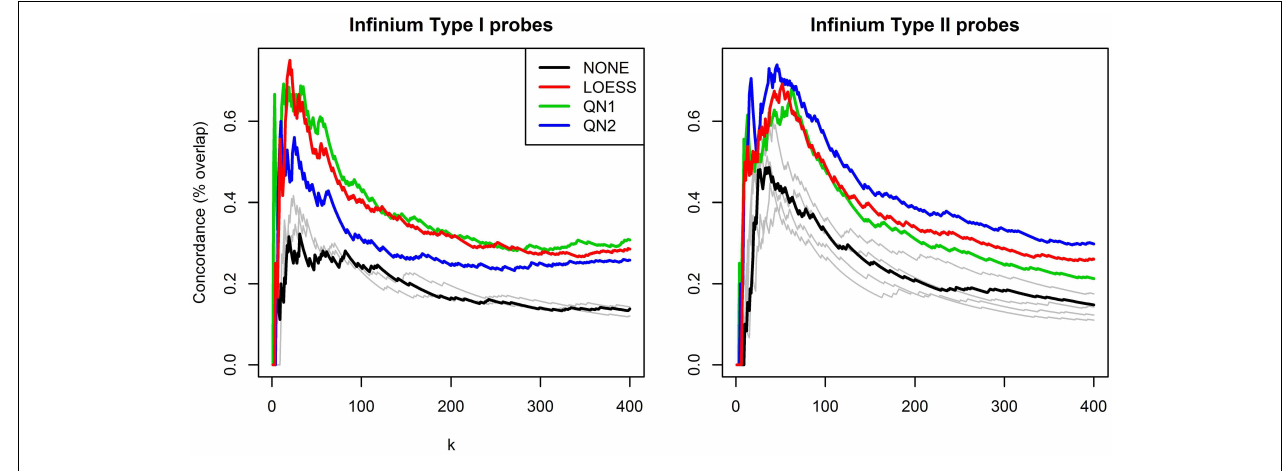
t -test. The plots show overlap percentage between the two rankings for the top k hits for P 1 and P 2 separately. For clarity, only the best performing methods are highlighted, the rest are plotted in gray.